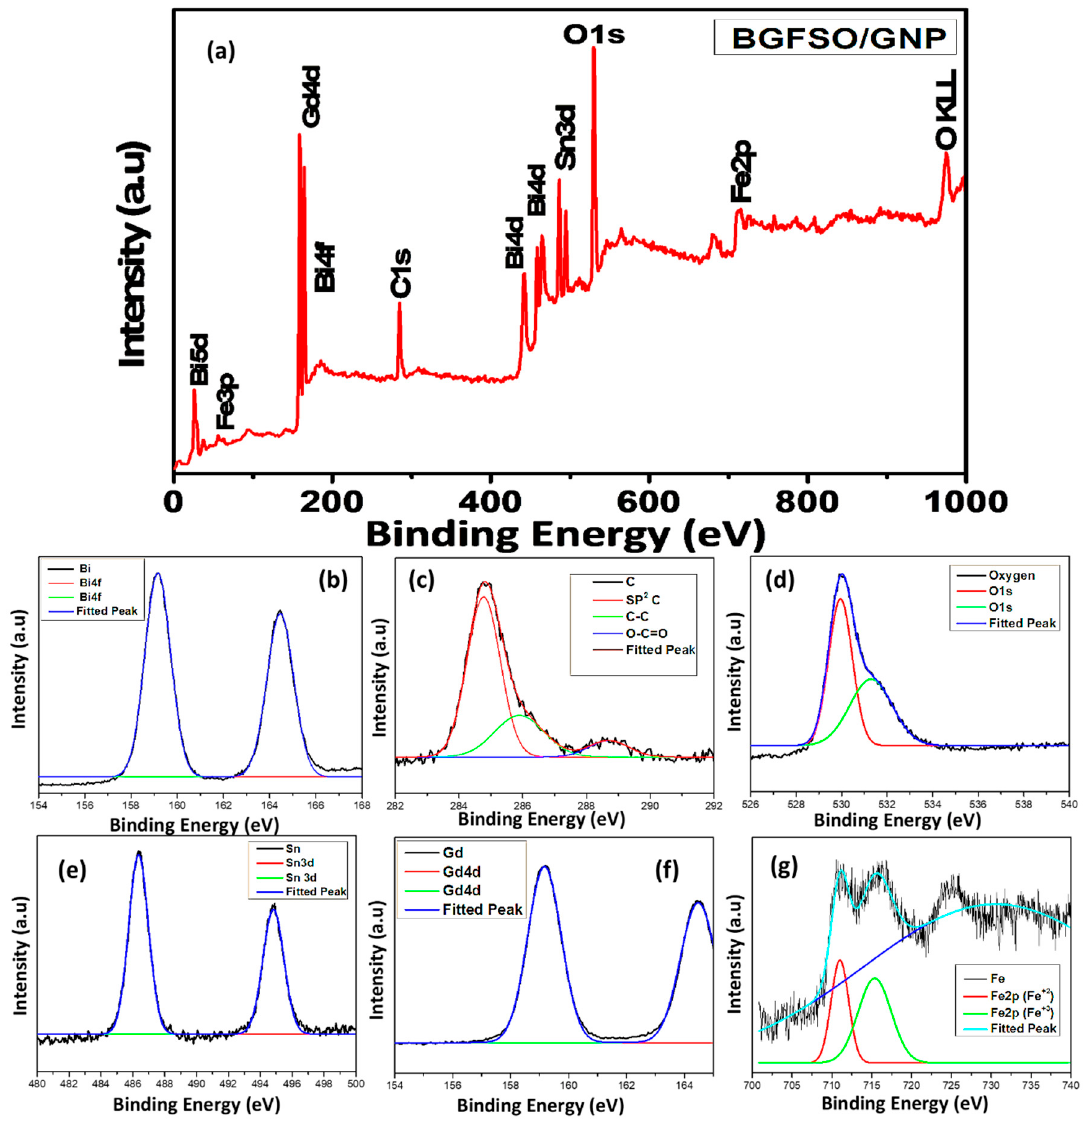
Figure 4. (a) . XPS analysis of BGFSO/GNP nanohybrid, (b) Lorentzian–Gaussian curve fitting of Bismuth (Bi), (c) Carbon (C), (d) Oxygen (O), (e) Tin (Sn), (f) Gadolinium (Gd) and (g) Iron